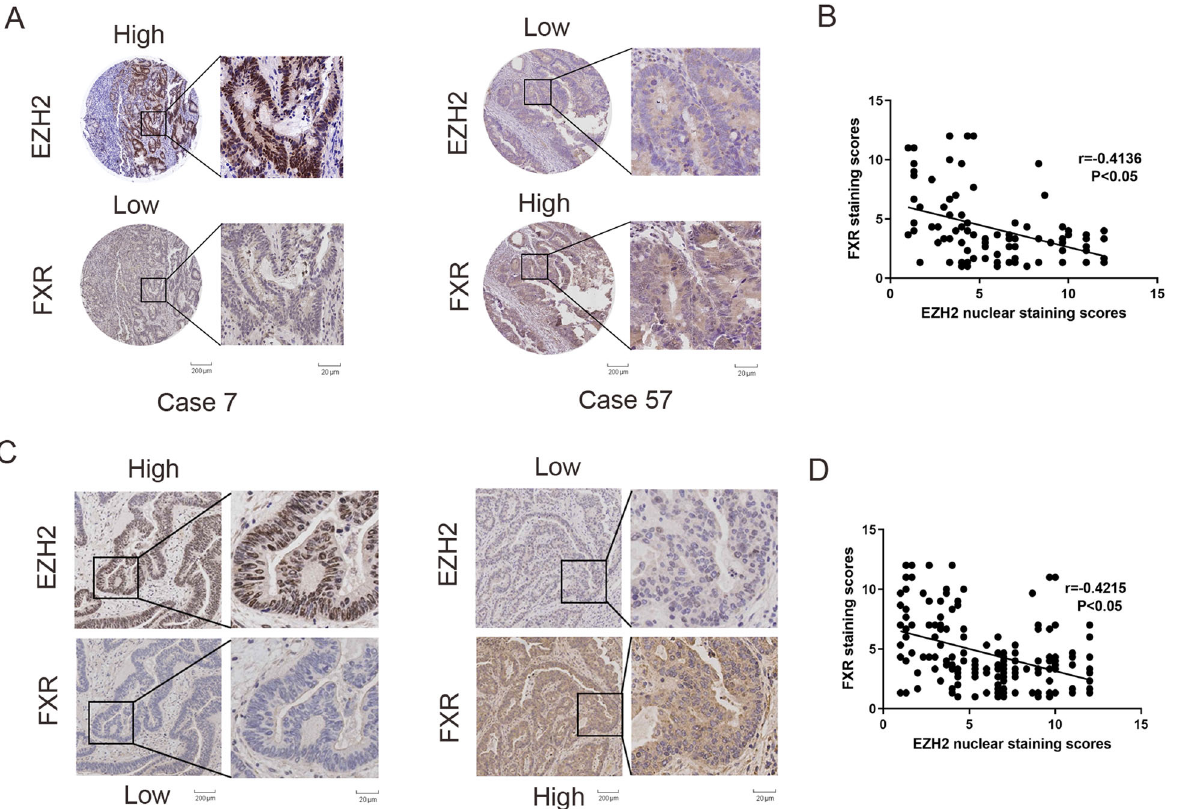
Fig. 2 An inverse correlation between EZH2 and FXR was found in the patients with colon cancer. a EZH2 and FXR expression in tissue microarrays purchased from Shaanxi Kexin Biotechnology Co., Ltd, including 90 pairs of CRC samples and paired NC tissues by IHC staining (cohort I). b Correlation analysis of EZH2 and FXR in CRC tissue microarrays. c EZH2 and FXR expression in an independent cohort of 403 colon cancer tissues sample from at the First Af fi liated Hospital of Xi ’ an Jiaotong University by IHC staining (cohort II). d Correlation analysis of EZH2 and FXR in 403 colon cancer tissues microarrays. All data are the mean ± SD of three independent experiments. * P <